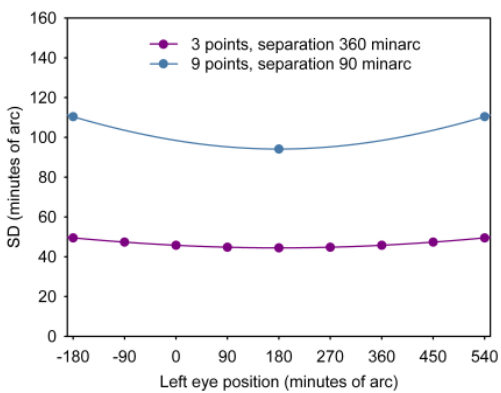
Figure 4: Two, theoretically extreme outcomes of the combined variations of point numbers and separation: at the same calibration range of 12 deg, more calibration points at smaller separations result in a reduction of SD following the